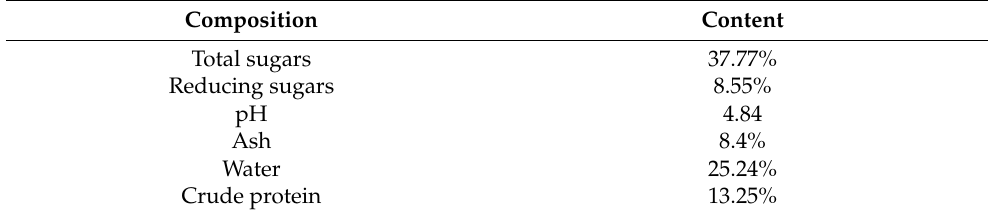
Table 1. Chemical composition of